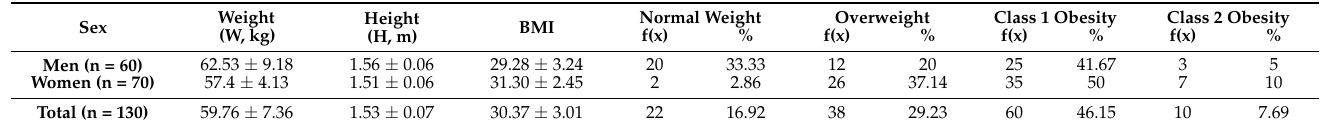
Table 2. Mean and standard deviation pertaining to weight, height, and